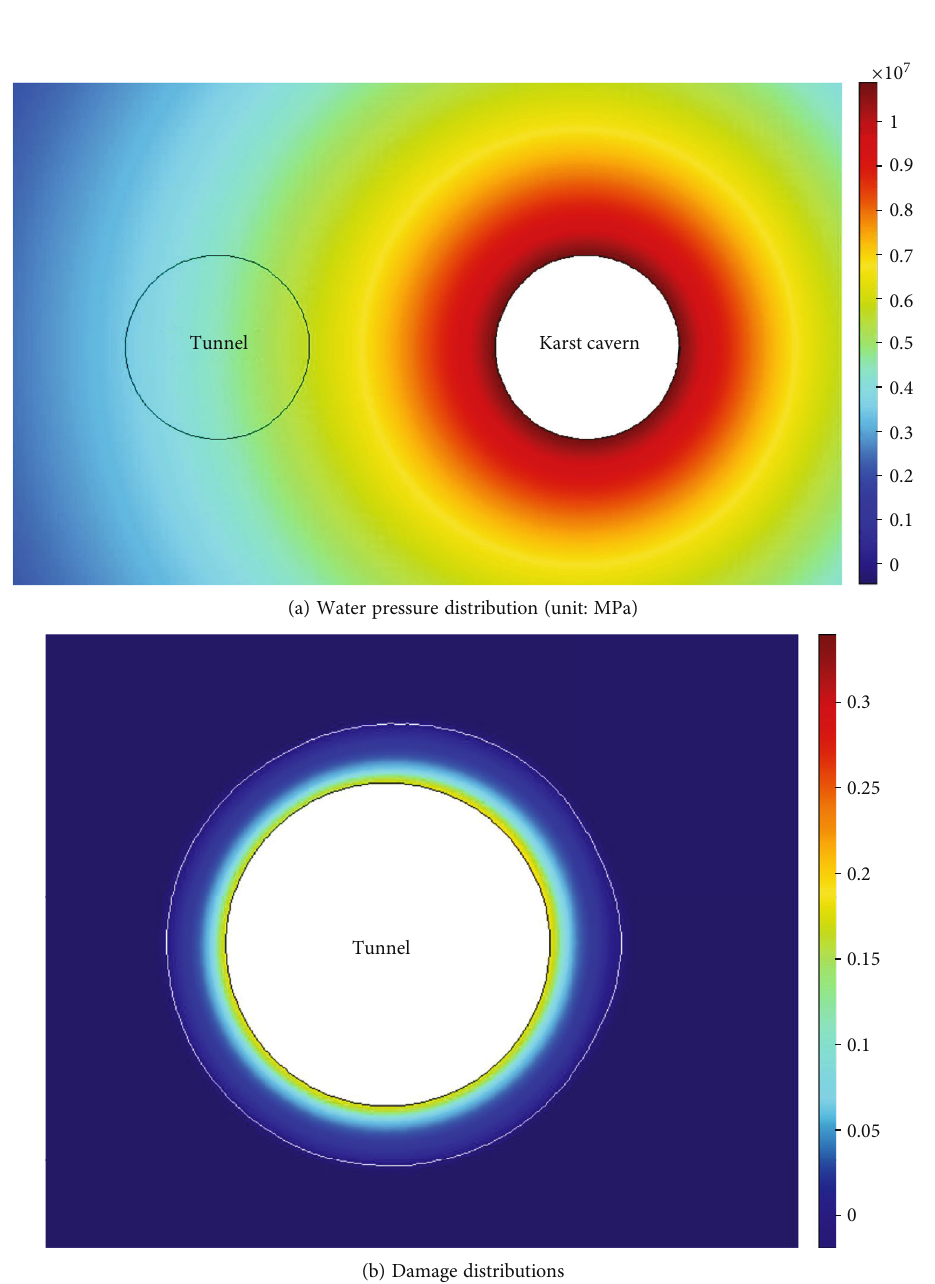
Figure 3: Water pressure distribution of tunnel before excavation and damage of surrounding rock in the stable stage.